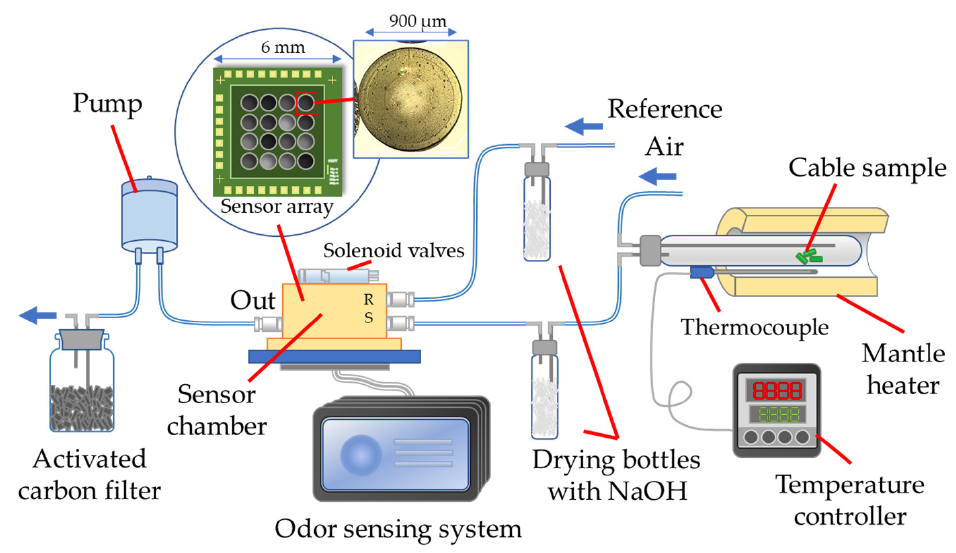
Figure 1. Experimental devices used in this study.